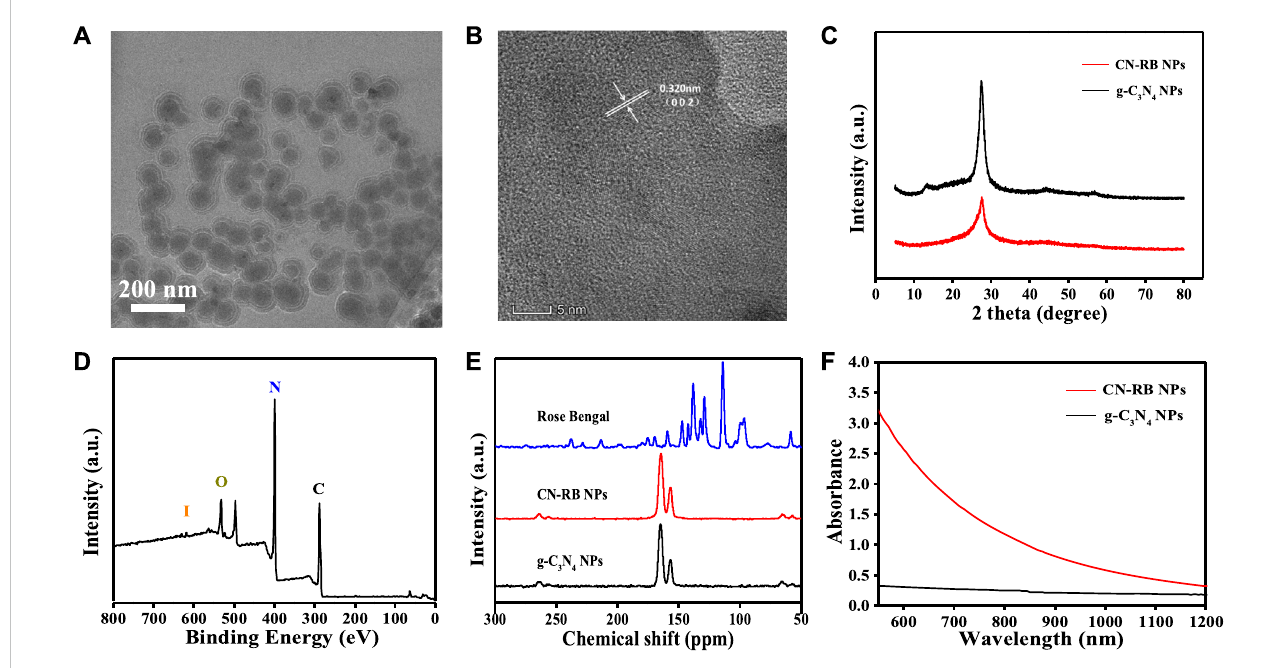
FIGURE 1 (A) TEM image of CN-RB NPs. (B) HRTEM of CN-RB NPs. (C) XRD patterns of CN-RB NPs and g-C Solid-state NMR 13C {1H} spectra of CN-RB NPs and g-C 3 N 4 NPs. (F) UV-vis absorption spectra of CN-RB NPs and g-C 3 N 4